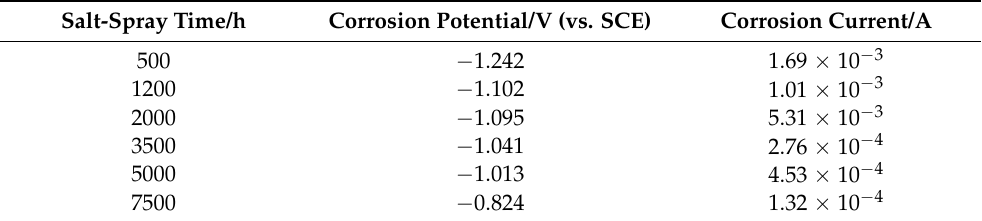
Figure 6. Polarization curves of the thermal-spray zinc coating after different salt-spray time. Table 1. Fitting data of polarization curves for thermal-spray zinc coating after different salt-spray time.